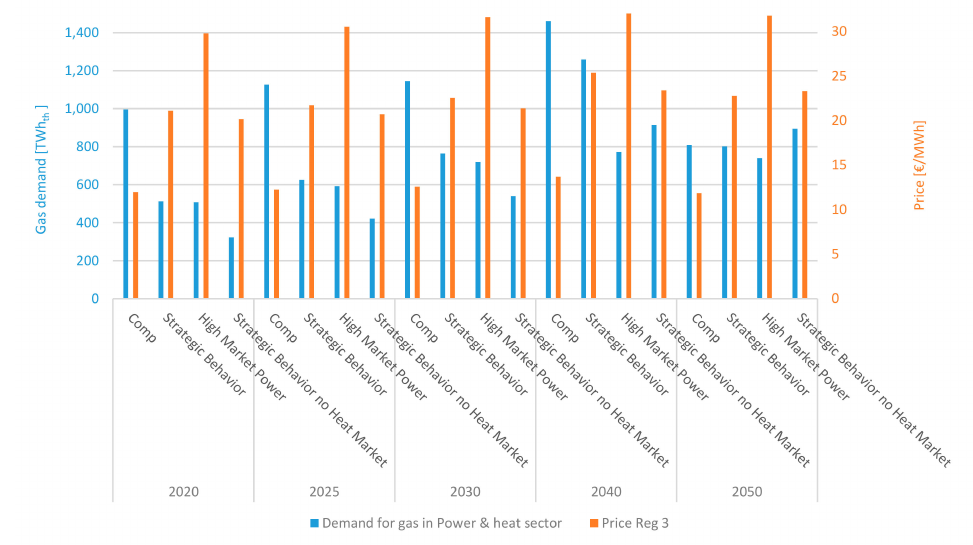
Figure 5. Developments of natural gas demand and gas price.